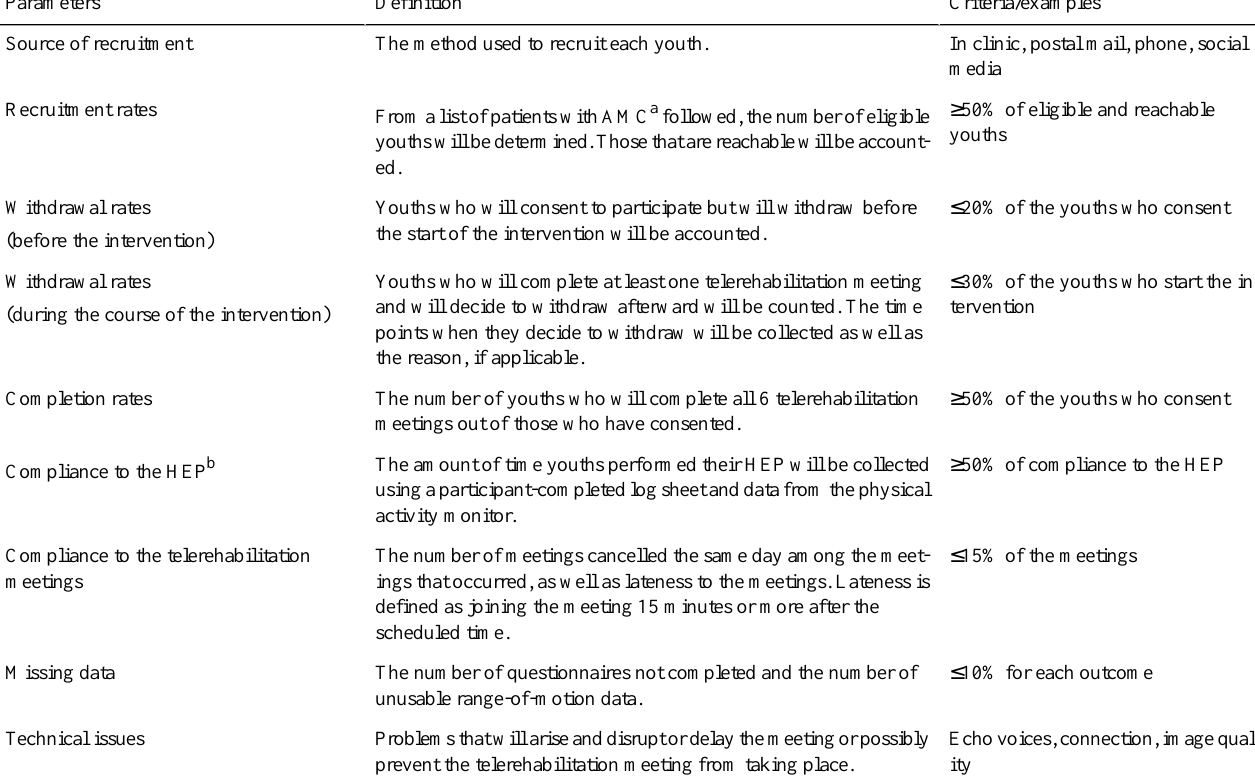
Table 1. Operationalization of the criteria to evaluate